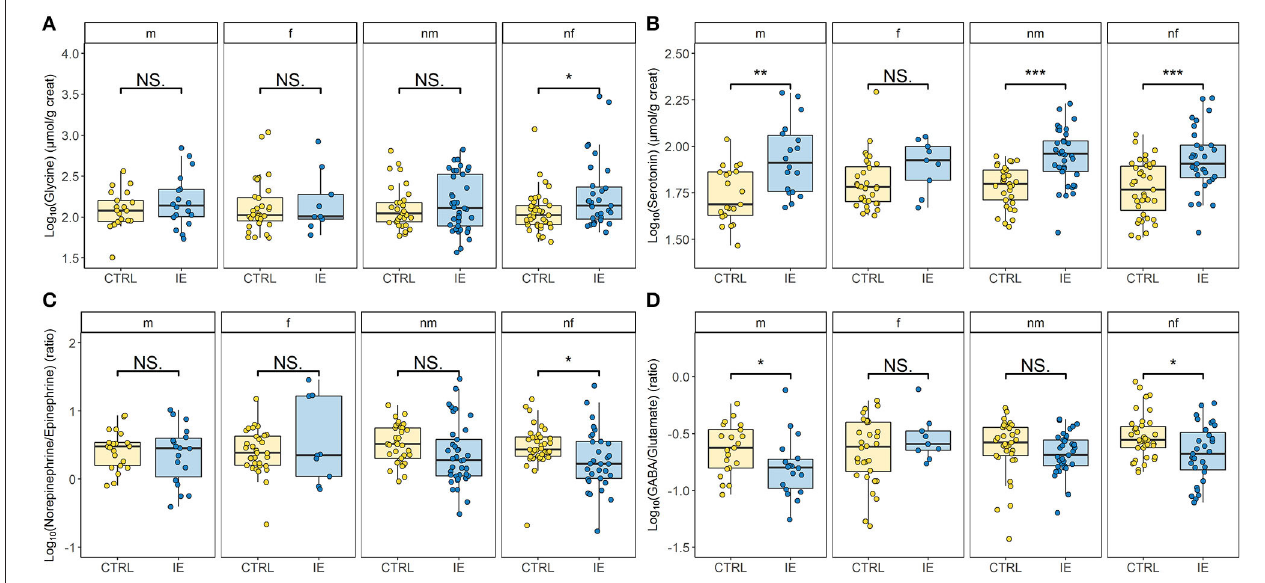
FIGURE 2 | Effects of the sex and neutering status on the urinary neurotransmitter profile of dogs with idiopathic epilepsy (IE) compared to the healthy control group (CTRL). (A) Glycine levels differ significantly in neutered females (nf) ( p ≤ 0.05) (IE: n = 22 dogs/31 samples vs. CTRL: n = 39 dogs/39 samples). (B) Serotonin levels differ significantly in intact males (m) ( p ≤ 0.01) (IE: n = 11 dogs/18 samples vs. CTRL n = 21 dogs/21 samples), neutered males (nm) ( p ≤ 0.001) (IE: n = 24 dogs/37 samples vs. CTRL n = 33 dogs/33 samples) and neutered females ( p ≤ 0.001) (IE: n = 22 dogs/31 samples vs. CTRL n = 39 dogs/39 samples). (C) The norepinephrine/epinephrine ratio differs significantly in neutered females ( p ≤ 0.05) (IE: n = 22 dogs/31 samples vs. CTRL n = 39 dogs/39 samples). (D) The È -aminobutyric acid (GABA)/glutamate ratio differs significantly in intact males ( p ≤ 0.05) (IE: n = 11 dogs/18 samples vs. CTRL n = 21 dogs/21 samples) and neutered females ( p ≤ 0.05) (IE: n = 22 dogs/31 samples vs. CTRL n = 39 dogs/39 samples). In intact females (f) no significant difference (NS.) of all analysed neurotransmitter between the groups was found (IE: n = 5 dogs/9 samples vs. CTRL n = 21 dogs/21 samples). Data are presented as box-and-whisker plots (the median is represented by the central line, the 25th and the 75th percentile represent the lower and upper limit, and the length of the whiskers represent the 1.5 multiple of the interquartile range). Unpaired two-sided two-sample t -test and Wilcoxon–Mann–Whitney test were used to compare the urinary neurotransmitter excretion between dogs with epilepsy and the healthy control group. * p ≤ 0.05, ** p ≤ 0.01 and *** p ≤